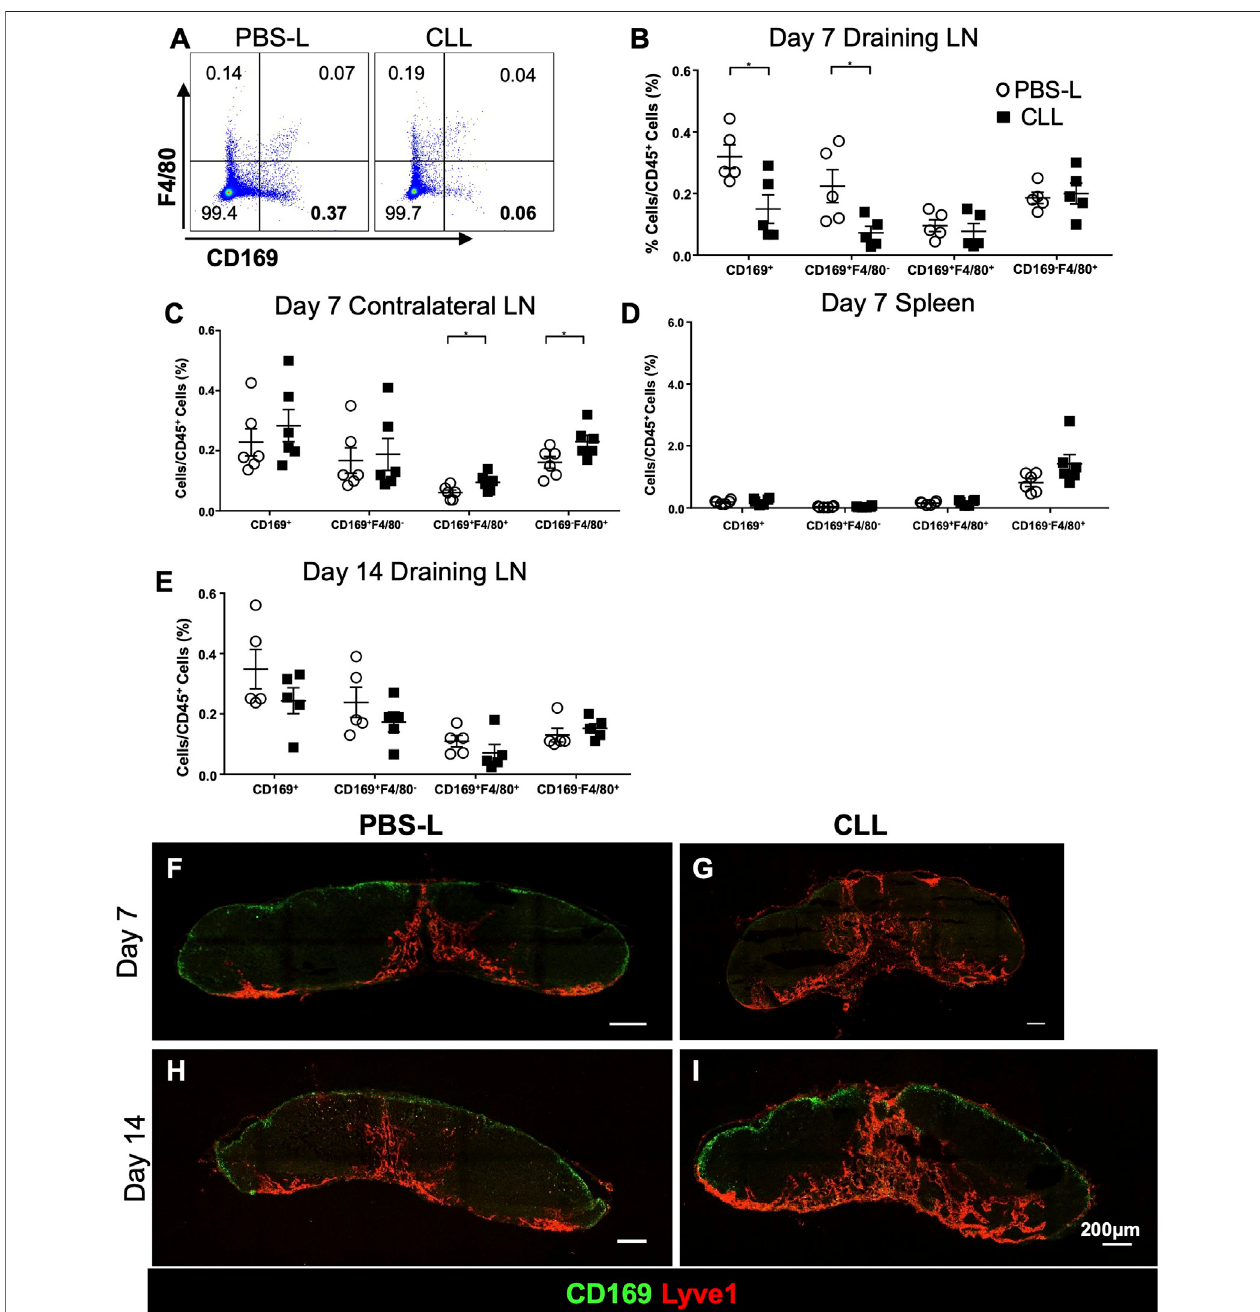
FIGURE 4 | Regional CLL delivery speci fi cally depletes SCS macrophages in the draining lymph node 7 days post-injection and are recovered 14 days post- injection. (A – D) Flow cytometry of the lymph nodes and spleens demonstrate the speci fi c depletion of CD169 + F4/80 − LN SCS macrophages 7 days post-intradermal fl ank injection ( n = 5 – 6 per group, repeated twice). Data is mean ± SEM. * p < 0.05. Unpaired,parametric student ’ s t -test. (E) Flow cytometry of the draining lymph node 14 days post-intradermal CLL fl ank injection ( n = 5 – 6 per group, in two separated experiments). (F – I) IF staining shows CLL fl ank injection depleted the CD169 + SCS macrophage layer in the draining lymph node 7 days post-intradermal injection. The macrophages are recovered 14 days post-intradermal injection. Images are representative of n = 5 per group, in two separated experiments.